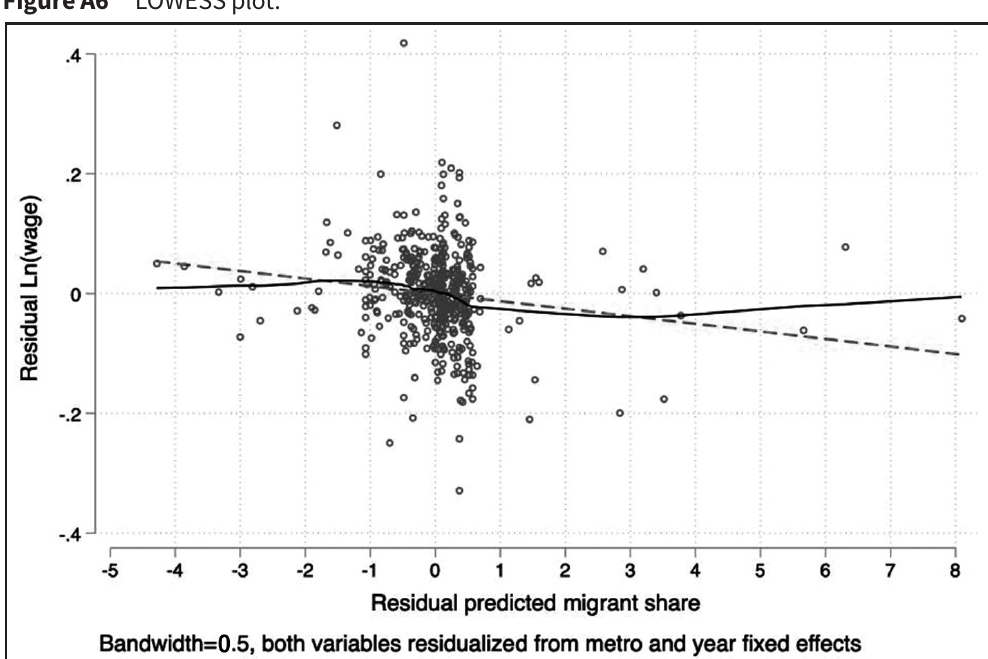
Figure A6 LOWESS plot.